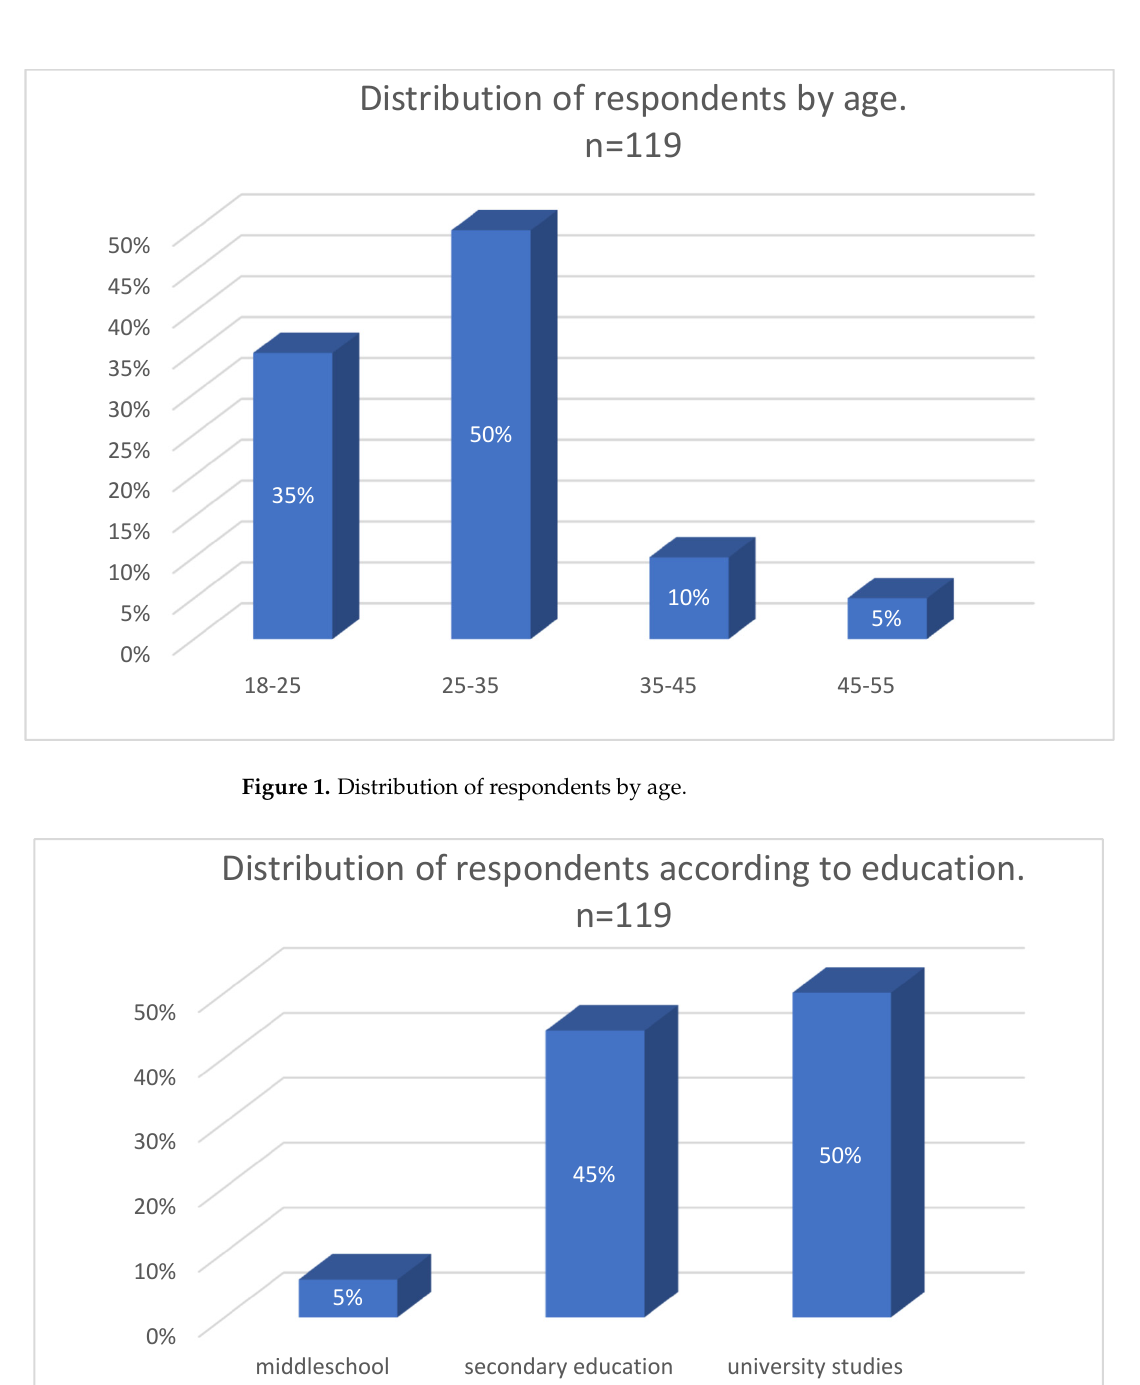
Figure 2. Distribution of respondents according to education level .